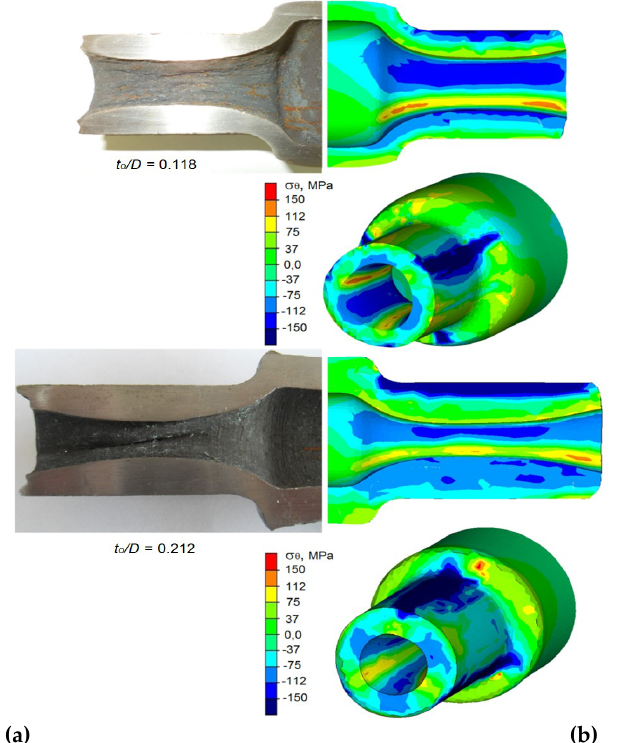
Figure 16. End steps of the forgings with a refraction on the hole surface: ( a ) forgings obtained during the experiment; ( b ) finite elements method (FEM)-determined distributions of the circumferential stresses.